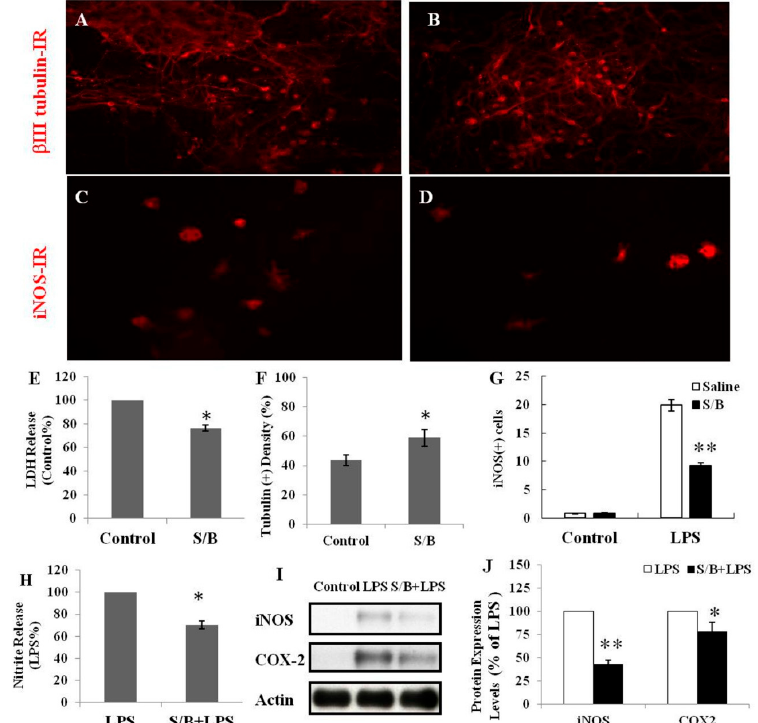
Figure 1. The effects of S/B remedy on cell survival or lipopolysaccharide (LPS) stimulation in spinal Figure 1. The e ff ects of S / B remedy on cell survival or lipopolysaccharide (LPS) stimulation in spinal cord neuron/glial cultures , wherein ( A ) shows Control culture, tubulin ‐ IR, ( B ) shows S/B ‐ treated cord neuron / glial cultures, wherein ( A ) shows Control culture, tubulin-IR, ( B ) shows S / B-treated cultures, tubulin-IR, ( C ) shows LPS-treated culture, iNOS-IR, ( D ) shows S / B + LPS-treated cultures, iNOS-IR ( E ) shows LDH release in Control or S / B-treated cultures, ( F ) shows tubulin( + ) density in Control or S / B treated cultures (F is the quantification of A and B), ( G ) shows iNOS-positive cells in each group of cells (G is the quantification of C and D), (H) shows the amount of nitrite release in each group of cells, ( I ) shows Protein expression of LPS- or S / B + LPS-treated cultures, and ( J ) shows quantitative results of iNOS or COX2 expression levels in I. The symbols “*” and “**” indicate statistical significance by one-way ANOVA and Bonferroni t -test at p < 0.05 (S / B vs. Control or S / B + LPS- treated vs. LPS-treated cells) and p < 0.01 (S / B + LPS-treated vs. LPS- treated cells),